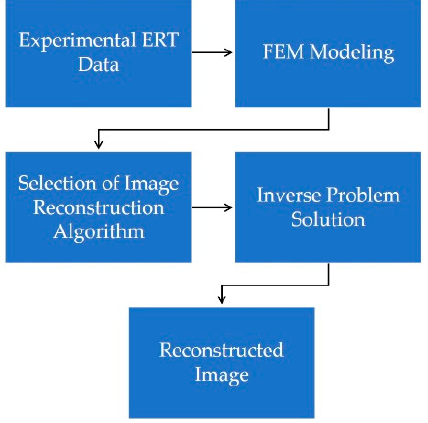
Figure 7. Image reconstruction procedure followed by EIDORS.